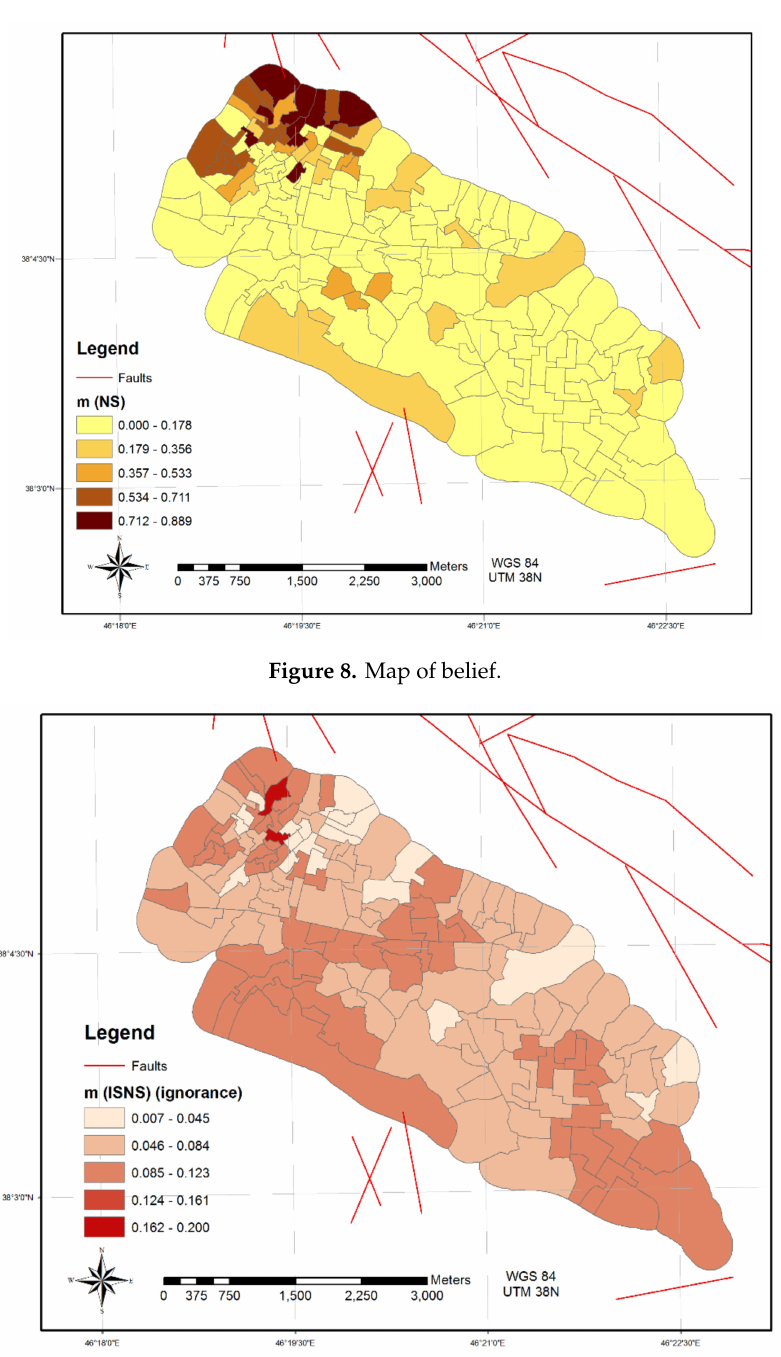
Figure 9. Map of